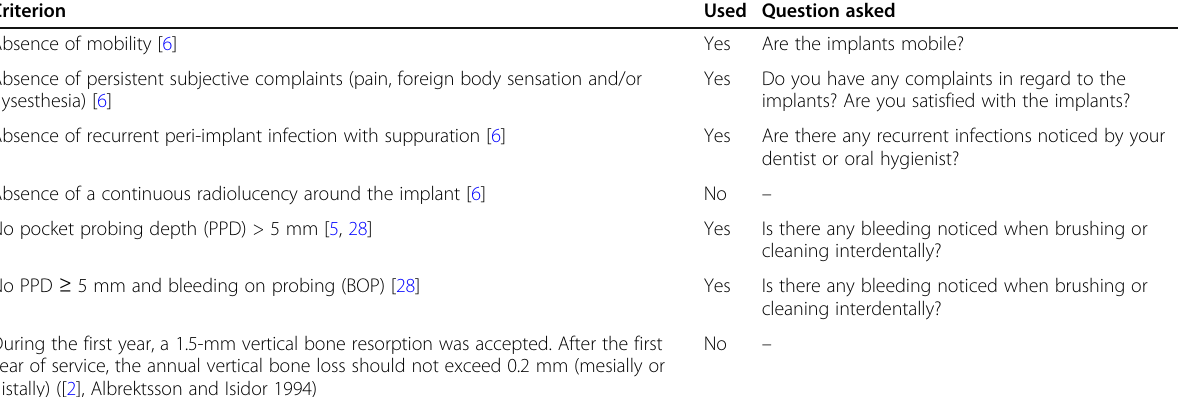
Table 1 Criteria used to measure success rate of dental implants